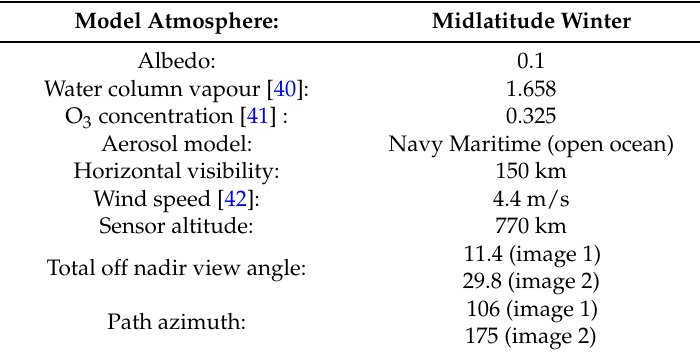
Table 1. Atmospheric correction parameters.